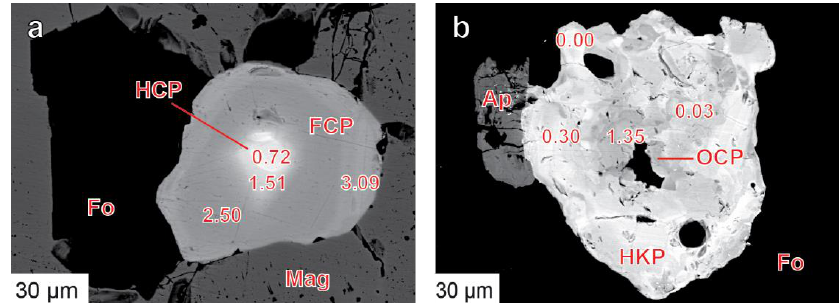
Figure 9. Zonal crystals of pyrochlore: ( a ) primary zonation of hydroxycalciopyrochlore– fluorcalciopyrochlore crystal from magnetite-forsterite phoscorite 1010/243.7; ( b ) secondary zonation in grain of oxycalciopyrochlore–U-rich hydroxykenopyrochlore from magnetite-forsterite phoscorite 987/2.1. BSE-images of thin polished sections with indicated fluorine contents. Mineral abbreviations are in Section 2.